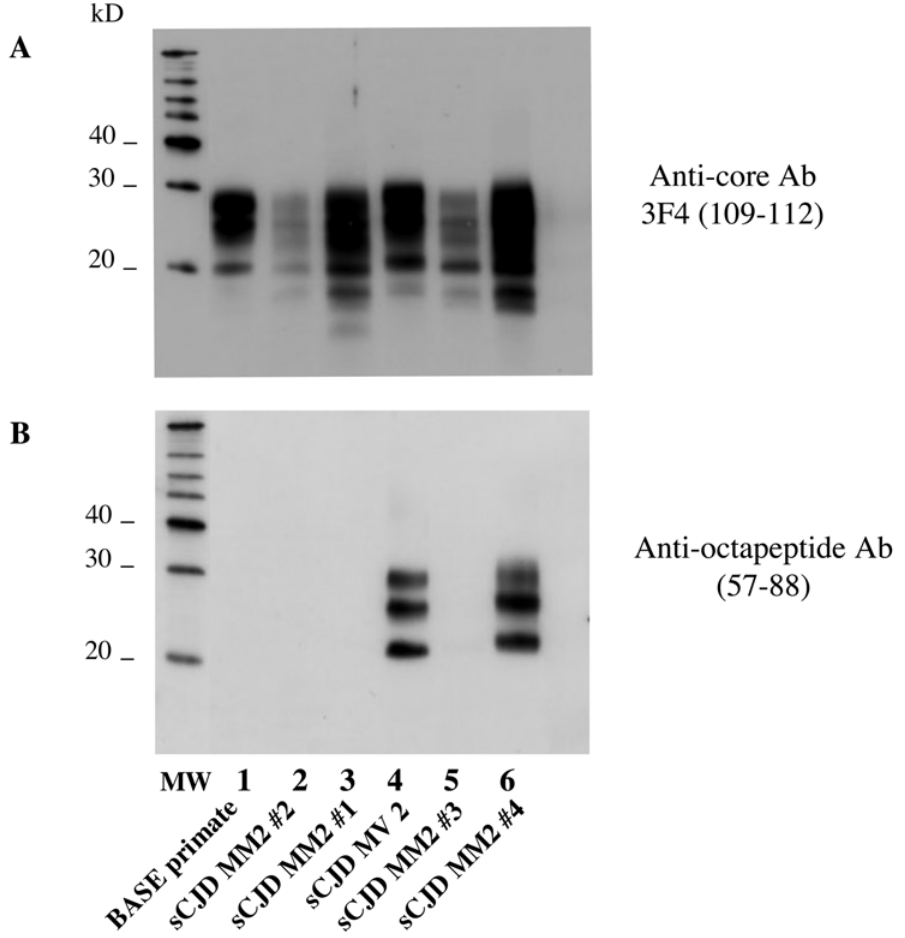
Figure 5. Electrophoretic analysis and differential sensitivity to proteolysis of PrPres in different MM2 CJD patients. PrPres from human brain homogenates (MM2 or MV2 subtypes of sCJD) and from primate experimentally infected with BASE were purified under high concentrations of proteinase K, and detected with monoclonal antibodies that recognize either the core (3F4, Panel A) or the octapeptide region (Panel B) of the protein.